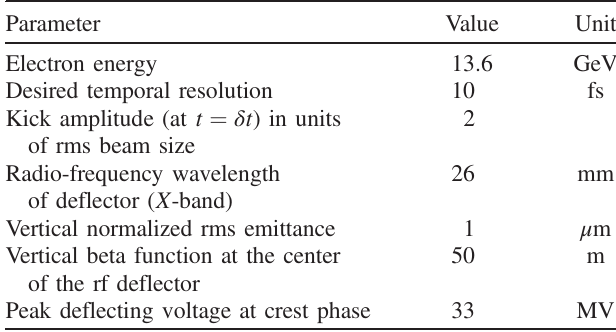
TABLE I. Parameter requirements for 10-fs temporal resolution using an X -band rf deflecting cavity (Table 1 from [7]).